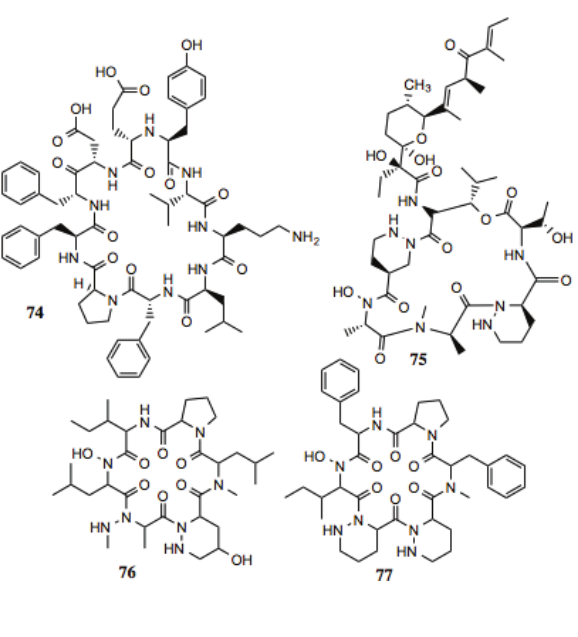
Figure 9. Cyclic